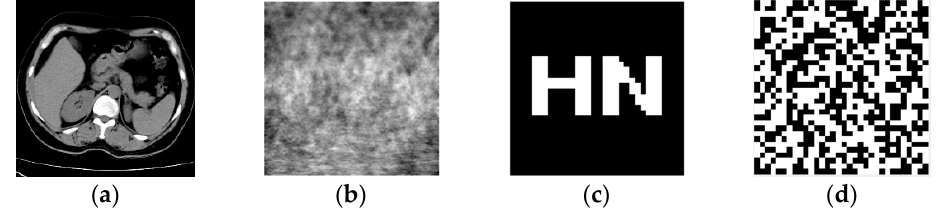
Figure 11. Medical image and watermarked image. Original medical image ( a ), encrypted medical image ( b ), original watermarked image ( c ), and encrypted watermarked image ( d ) .